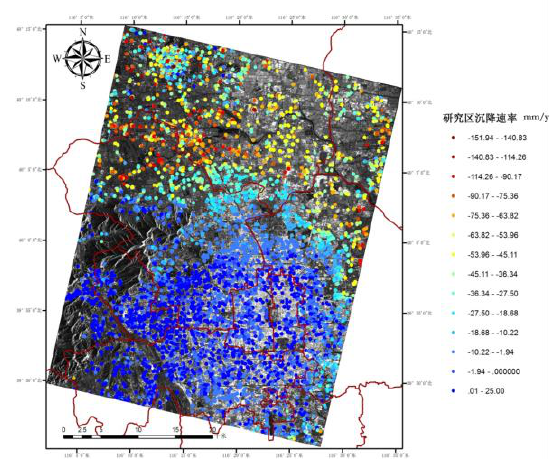
Figure 6. High coherent point time series sedimentation rate